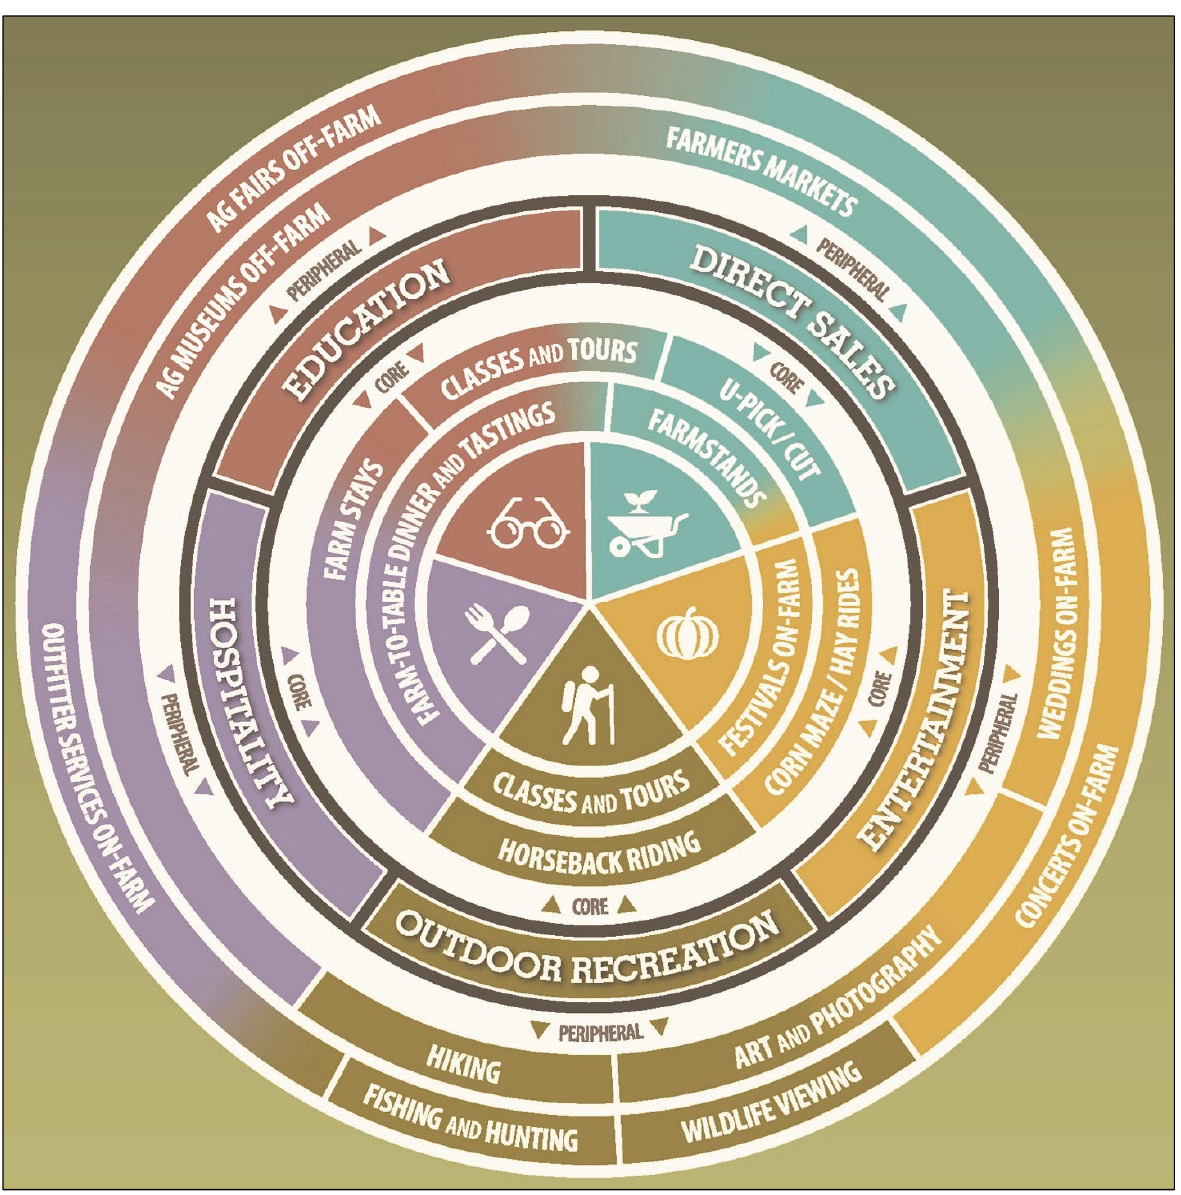
Figure 2. Five Categories of Agritourism including Direct Sales, Education, Hospitality, Outdoor Recreation, and Entertainment, and Examples of Core vs. Peripheral